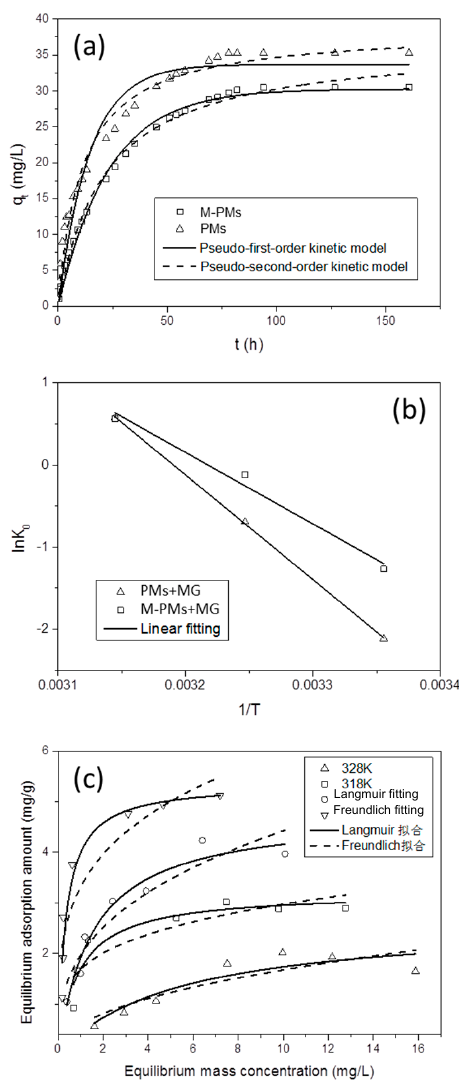
Figure 6. ( a ) Adsorption kinetics of M-PMs and PMs for MG (test conditions: at 35 ◦ C, pH 7, initial MG concentration = 10 mg/L, dosage of polymer microspheres = 0.05 g, and volume of the MG solution = 250 mL). ( b ) Plot of ln K 0 as a function of 1/ T (test conditions: pH 7, initial MG concentration = 10 mg/L, dosage of polymer microspheres = 0.01 g, and volume of the MG solution = 10 mL). ( c ) Isothermal adsorption patterns for the adsorption of MG by M-PMs, along with the Langmuir and Freundlich fittings (test conditions: pH 7, initial MG concentration = 3 mg/L, dosage of polymer microspheres = 0.01 g, and volume of the MG solution = 4